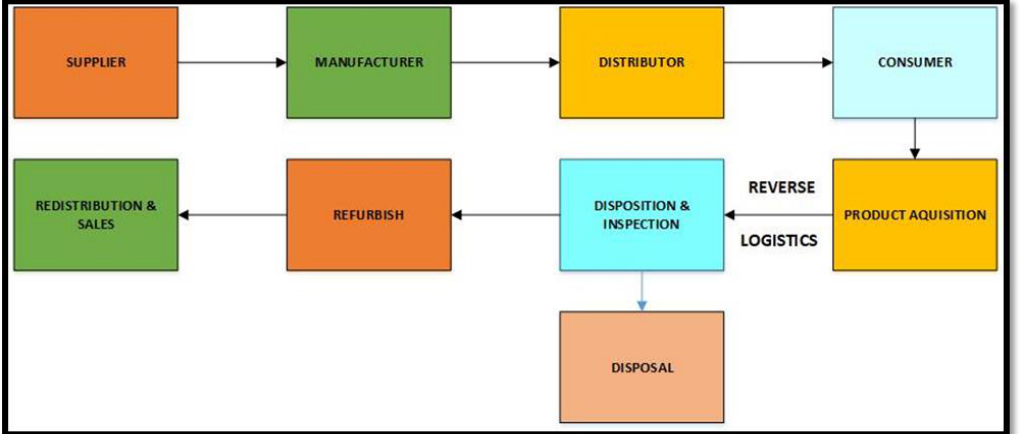
Figure.3. Closed-Loop Supply Chain for E-Waste Source: (Doan et al.,